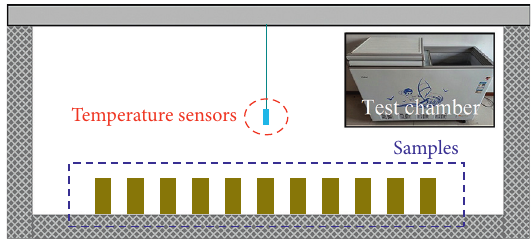
Figure 6: Low-temperature environment test chamber. Table 2: Saturation variations of sample during the WD/WDFT processes.